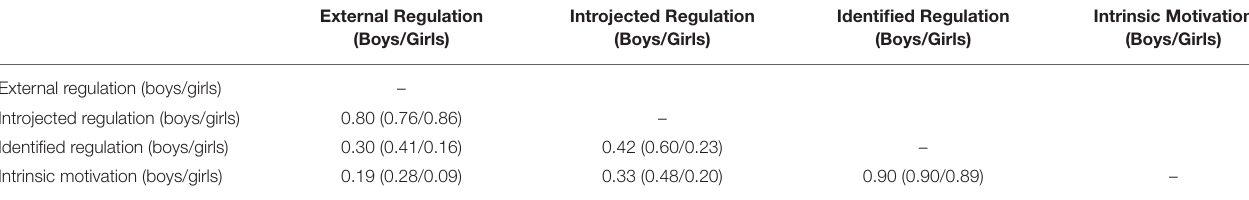
TABLE 5 | Latent correlations between the four scales of the German version of the 28-item